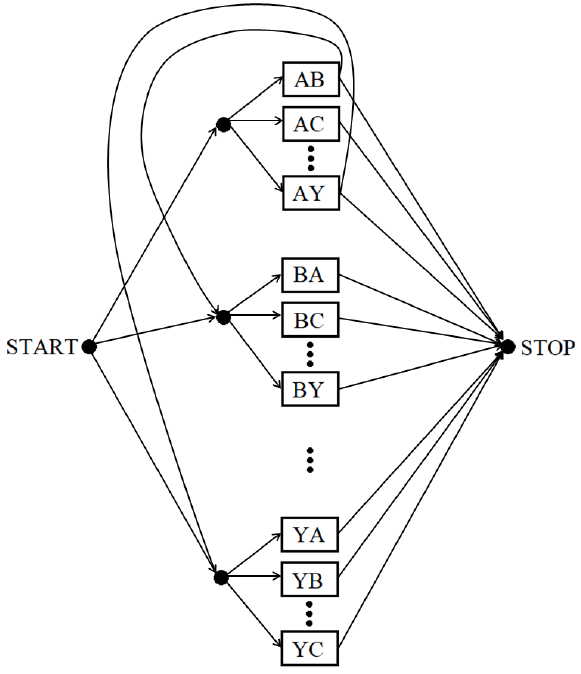
Figure 5. The structure of connected transition models for the method independent from the acronym dictionary. Every transition model is represented by a rectangular block. For the sake of clarity, only a few of all the blocks and connections are